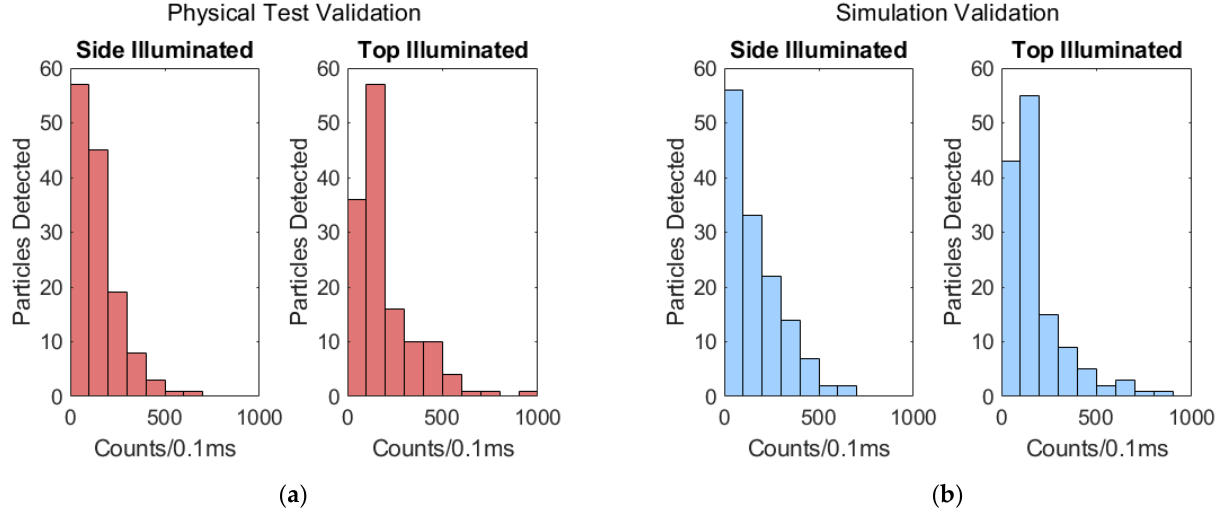
Figure 8. Comparison of signal distributions for model validation: ( a ) The physical test signal distributions for both side- and top-illuminated devices; ( b ) The simulated signal distributions for side- and top-illuminated models.